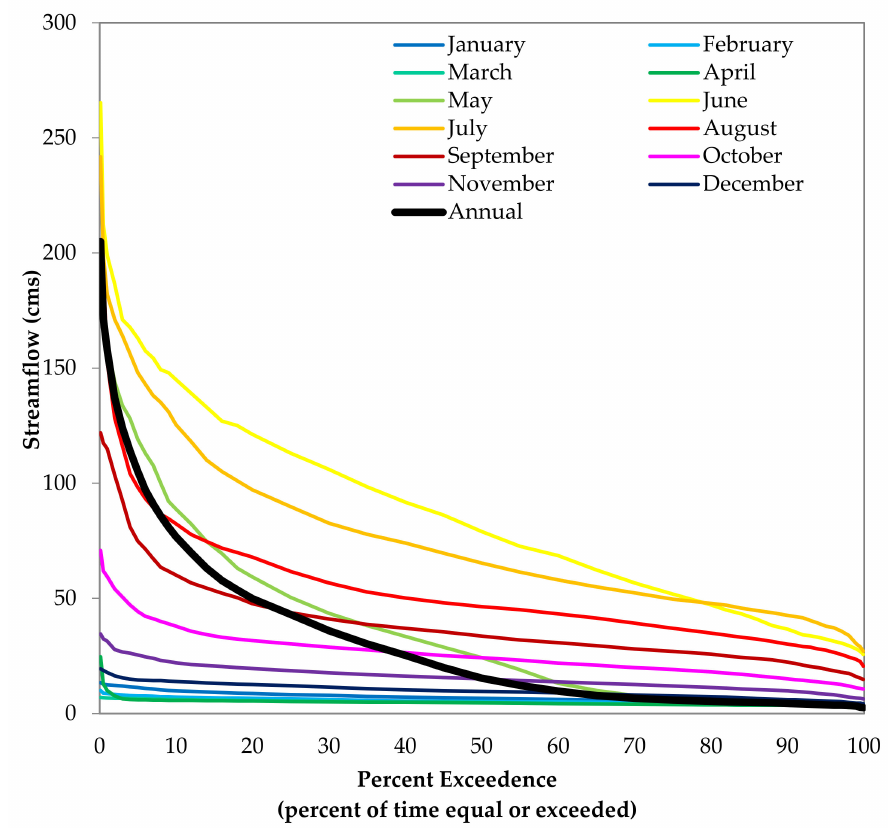
Figure 3. Percentiles and streamflow duration curves for the study period